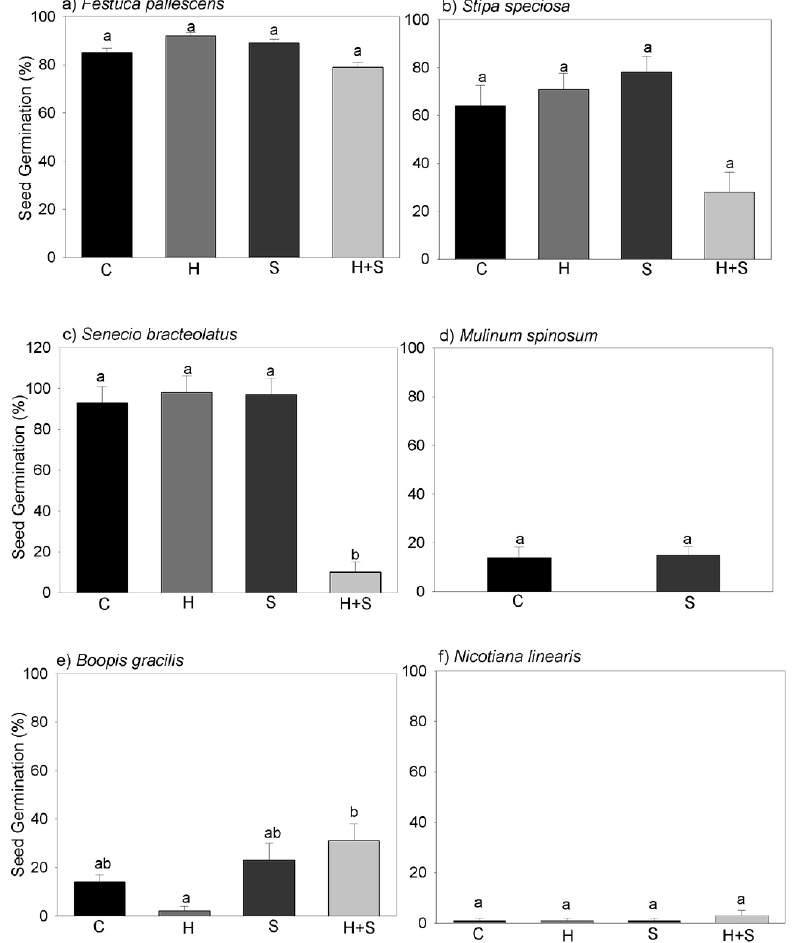
Fig. 1. Mean percentage germination ( ± SE) at Control (C), Heat at 80 ◦ C for 5min (H), Smoke for 60min (S), Heat+Smoke (H+S) treatments for the six species (a) Festuca pallescens (b) Stipa speciosa (c) Senecio bracteolatus (d) Mulinum spinosum (e) Boopis gracilis and (f) Nicotiana linearis . Note the change in scale for S. bracteolatus . Different letters indicate significant differences between final germination after 13weeks of